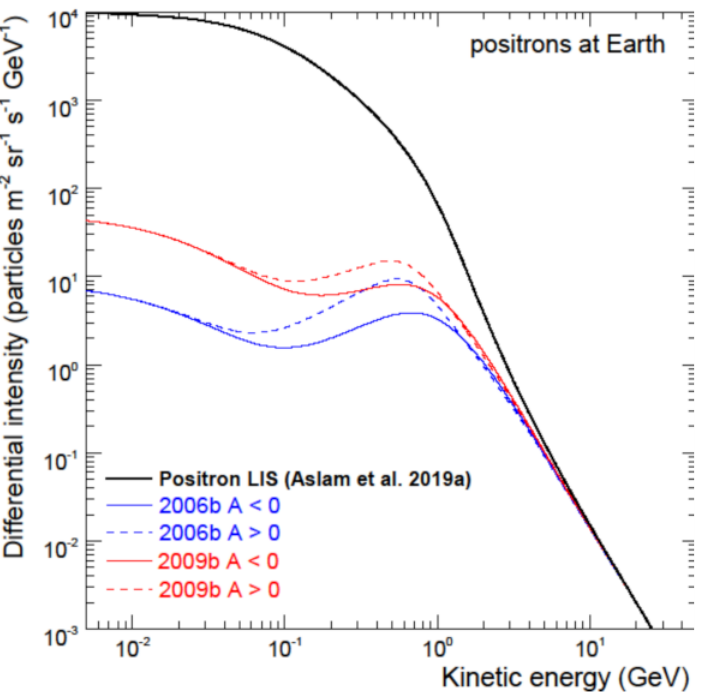
Figure 9. Predicted drift effects for positrons are displayed based on the differences in computed spectra between A > 0 (dashed lines) and A < 0 drift cycles (coloured solid lines). Modulation conditions applicable to the second halves of 2006 and 2009, indicated at 2006b and 2009b, are simulated for both cycles. The predicted spectra are shown at Earth with respect to the assumed VLIS] at 122 AU (black solid line). Figure is adapted from